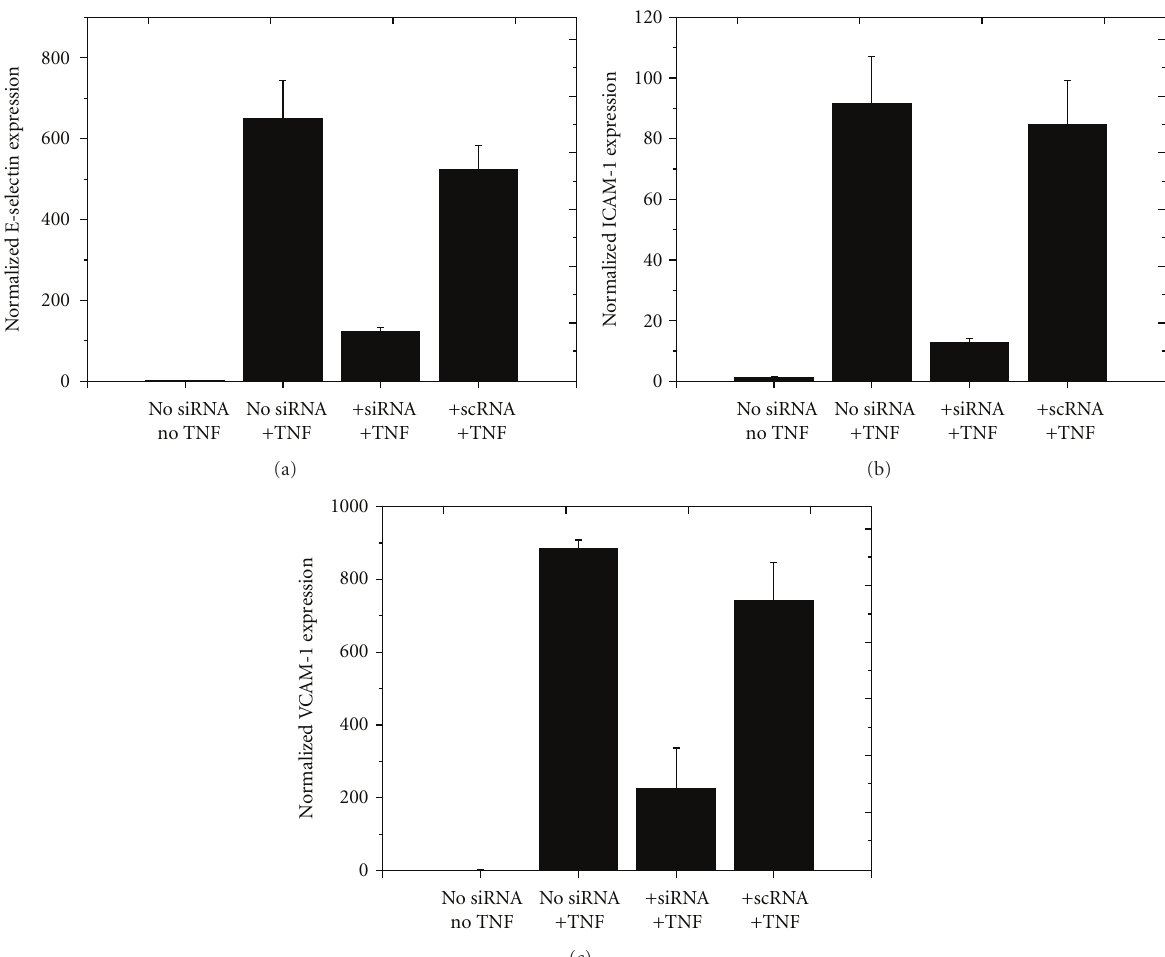
Figure 5: E ff ects of siRNA and TNF- α treatment on ESELE, ICAM-1, and VCAM-1 mRNA levels. Experiments and groups were as described in Figure